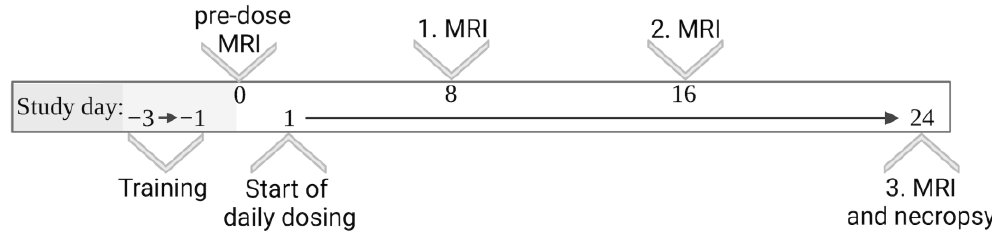
Figure 2. Study design — main study.